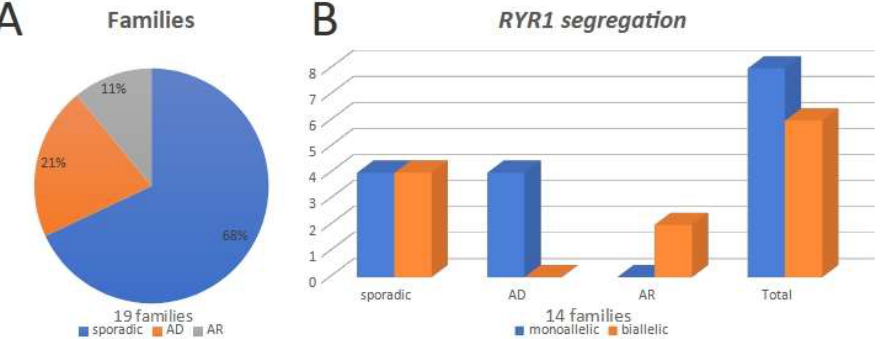
Figure 1. ( A )—Distribution of the studied families, according to the pedigrees. ( B )—Distribution of the 14 families with genetic studies, according to the presence of mono or biallelic variants in RYR1 . Imaging studies were used to guide the choice for the best site for muscle biopsy.